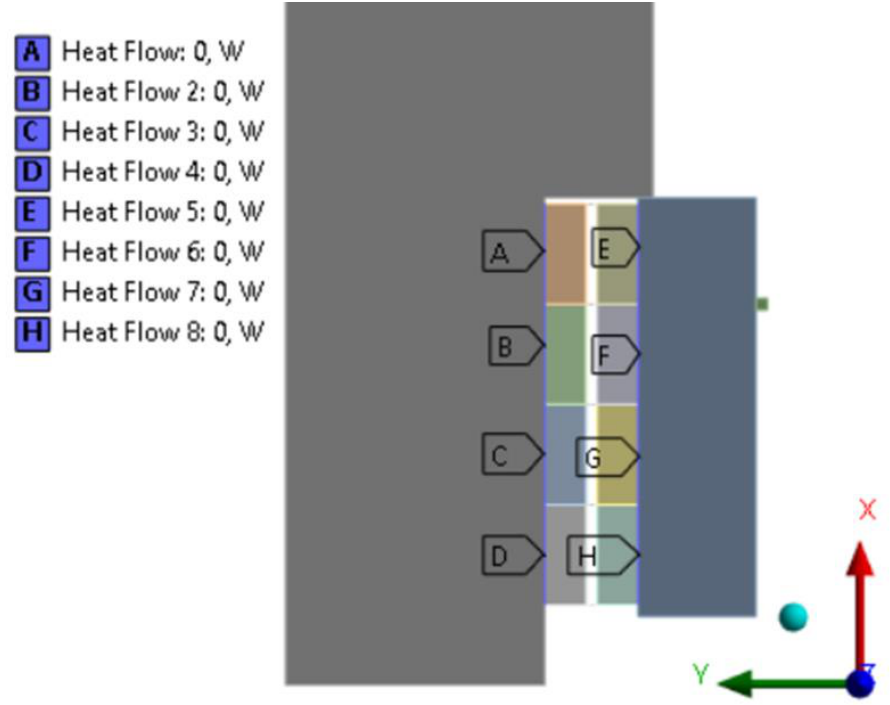
Figure 6. Heat flow applied among mating friction surfaces modeling energy transfer.